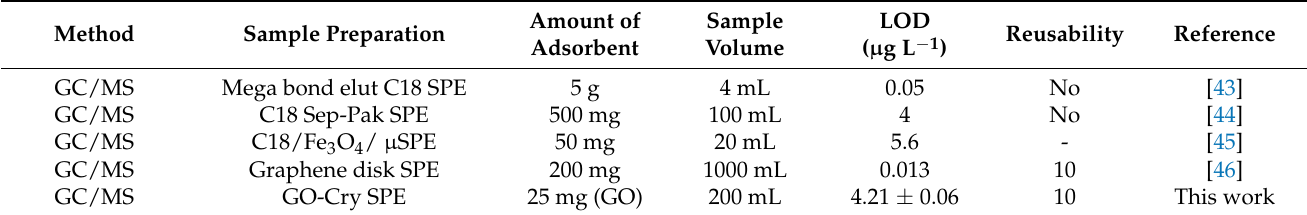
Table 3. Comparison of GO-Cry and other reported methods for the analysis of BaP.